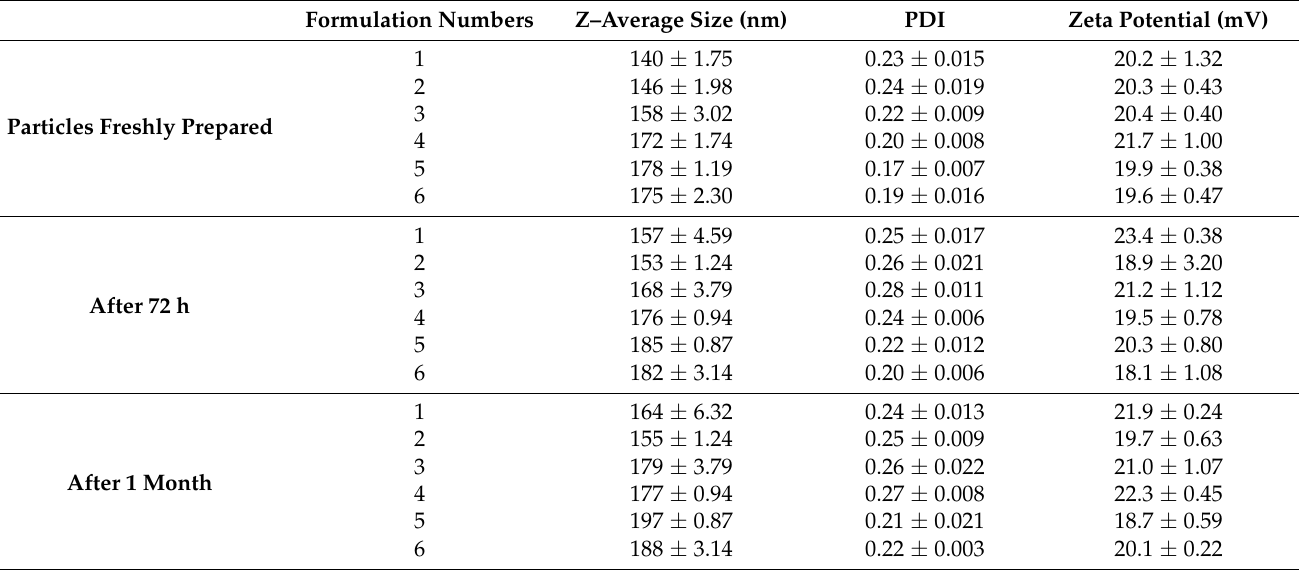
Table 4. Properties of NPs prepared in three independent samples with the best formulation con- ditions achieved previously, to check the reproducibility of the formulation technique and the NPs stability over the time. Formulations 1 to 3 without pDNA, 4 to 6 with